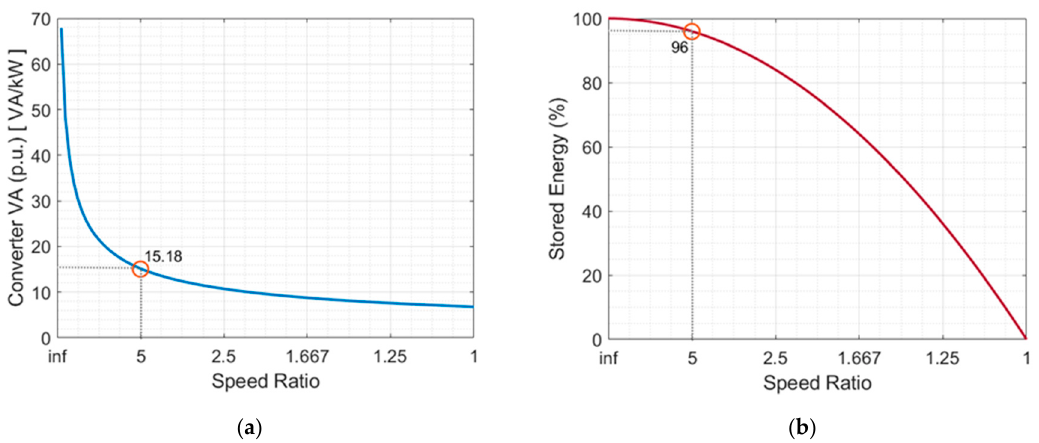
Figure 5. Speed ratio trade-off plots: ( a ) converter Volt-Ampere (VA) rating vs. speed ratio (VA rating is expressed in per unit with respect of the machine rated power); ( b ) stored energy vs. speed ratio.